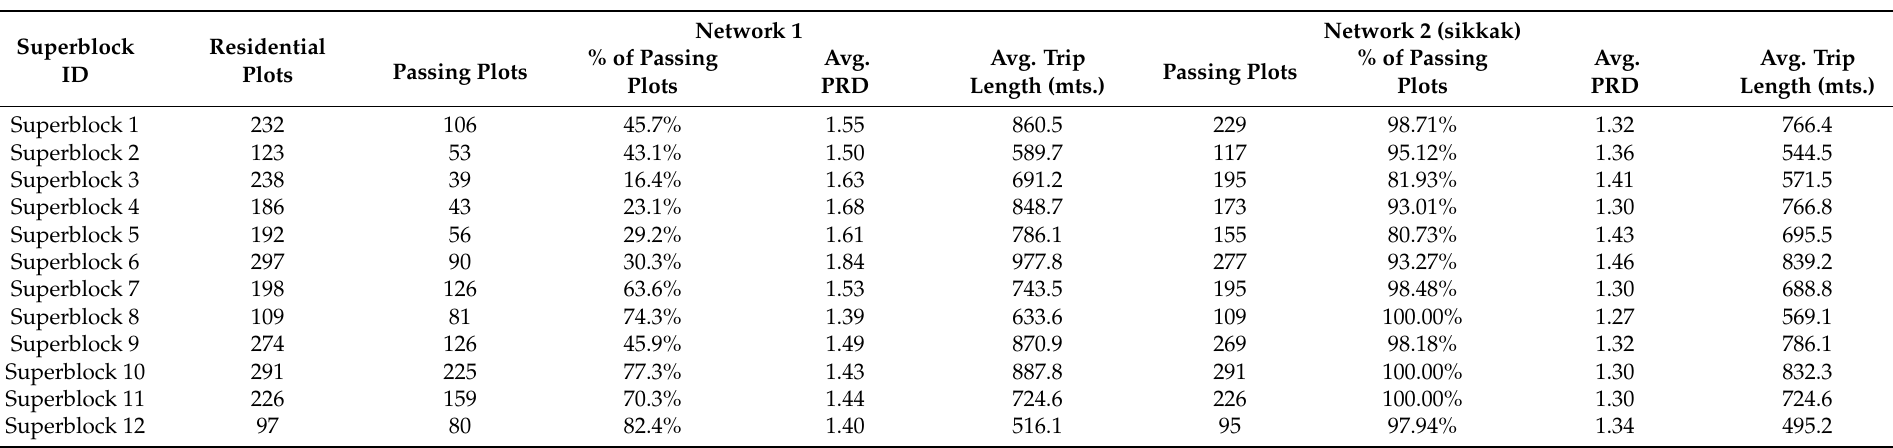
Table 2. Descriptive statistics of the all-residential-plots-to-all-residential-plots route directness analysis of network 1 in columns (3–6). Results of using Network 2—the network that includes sikkak—are presented in columns (7–9).